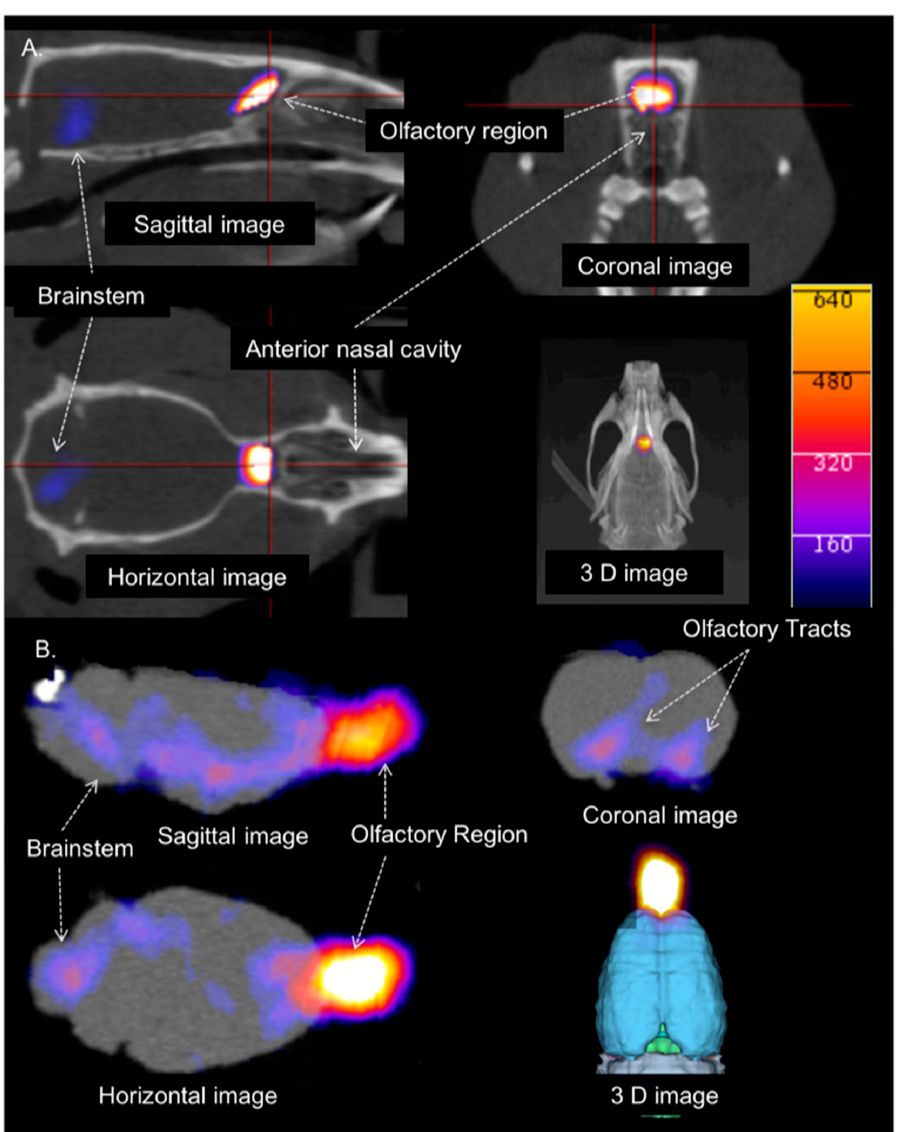
Figure 5. PET/CT brain activity at 1 h following INDD. ( A ) Sagittal, coronal, axial, and 3D images demonstrating the PET activity in the olfactory and brainstem regions. Oropharyngeal activity outside the intracranial ROI was suppressed. ( B ) Sagittal, coronal, axial, and 3D images demonstrating the PET activity in the olfactory and brainstem regions. Increased activity was found in the olfactory bulb, and to a lesser extent, in the basal forebrain structures, brainstem, and trigeminal ganglion. The scale bar intensity ranges from 0 to 640. By changing the upper and lower limits of the color scale, we can observe lower uptake distributions in the brain more readily.